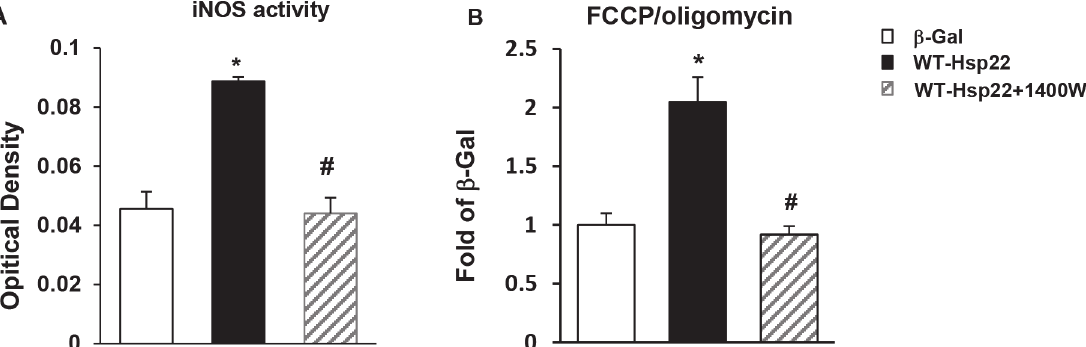
Fig 6. Hsp22 stimulates mitochondrial respiration through iNOS. A. iNOS activity in myocytes transfected with Ad-WT-Hsp22 in presence or in absence of 1400W, compared to β -Gal. Optical density represents the measured absorbance at 540 nm. * , P < 0.05 versus β -Gal; #, P < 0.05 vs Ad-WT-Hsp22 without 1400W. n = 5 per group. B. Mitochondrial respiration measured by Clark electrode in intact myocytes transfected with Ad-WT-Hsp22 in presence or in absence of the iNOS inhibitor 1400W, and compared to β -Gal control, as presented by the FCCP/oligomycin ratio. * , P < 0.05 versus β -Gal; #, P < 0.05 vs Ad- WT-Hsp22 without 1400W. n = 4 per